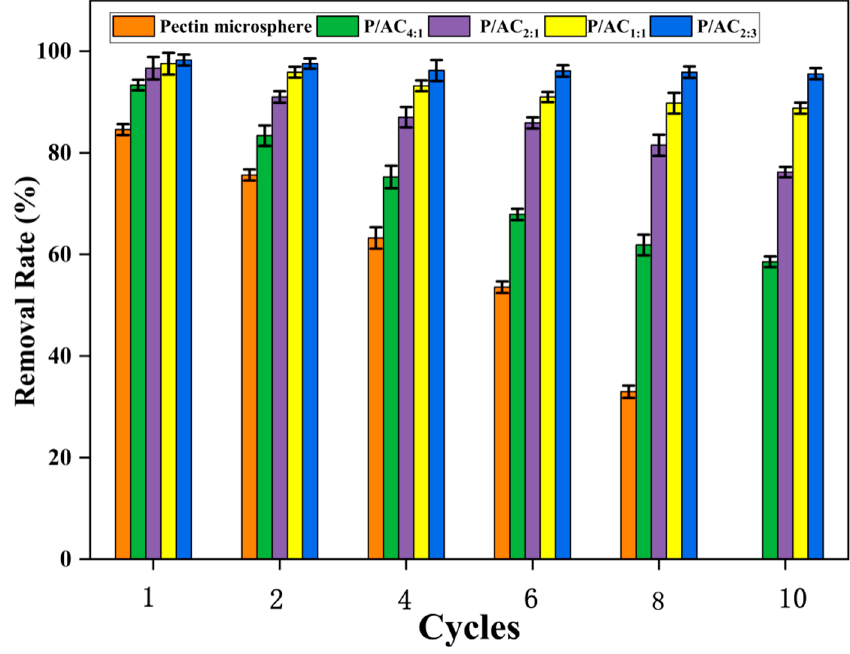
Figure 7. Efficiency of P/ACs on removal Pb 2+ during adsorption–desorption